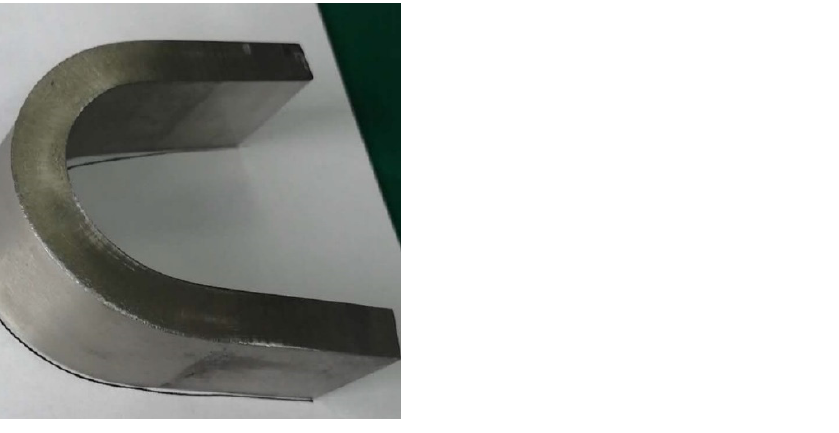
Figure 12. Result from the bending test with plunger size of 40 mm and bending angle of 180°.